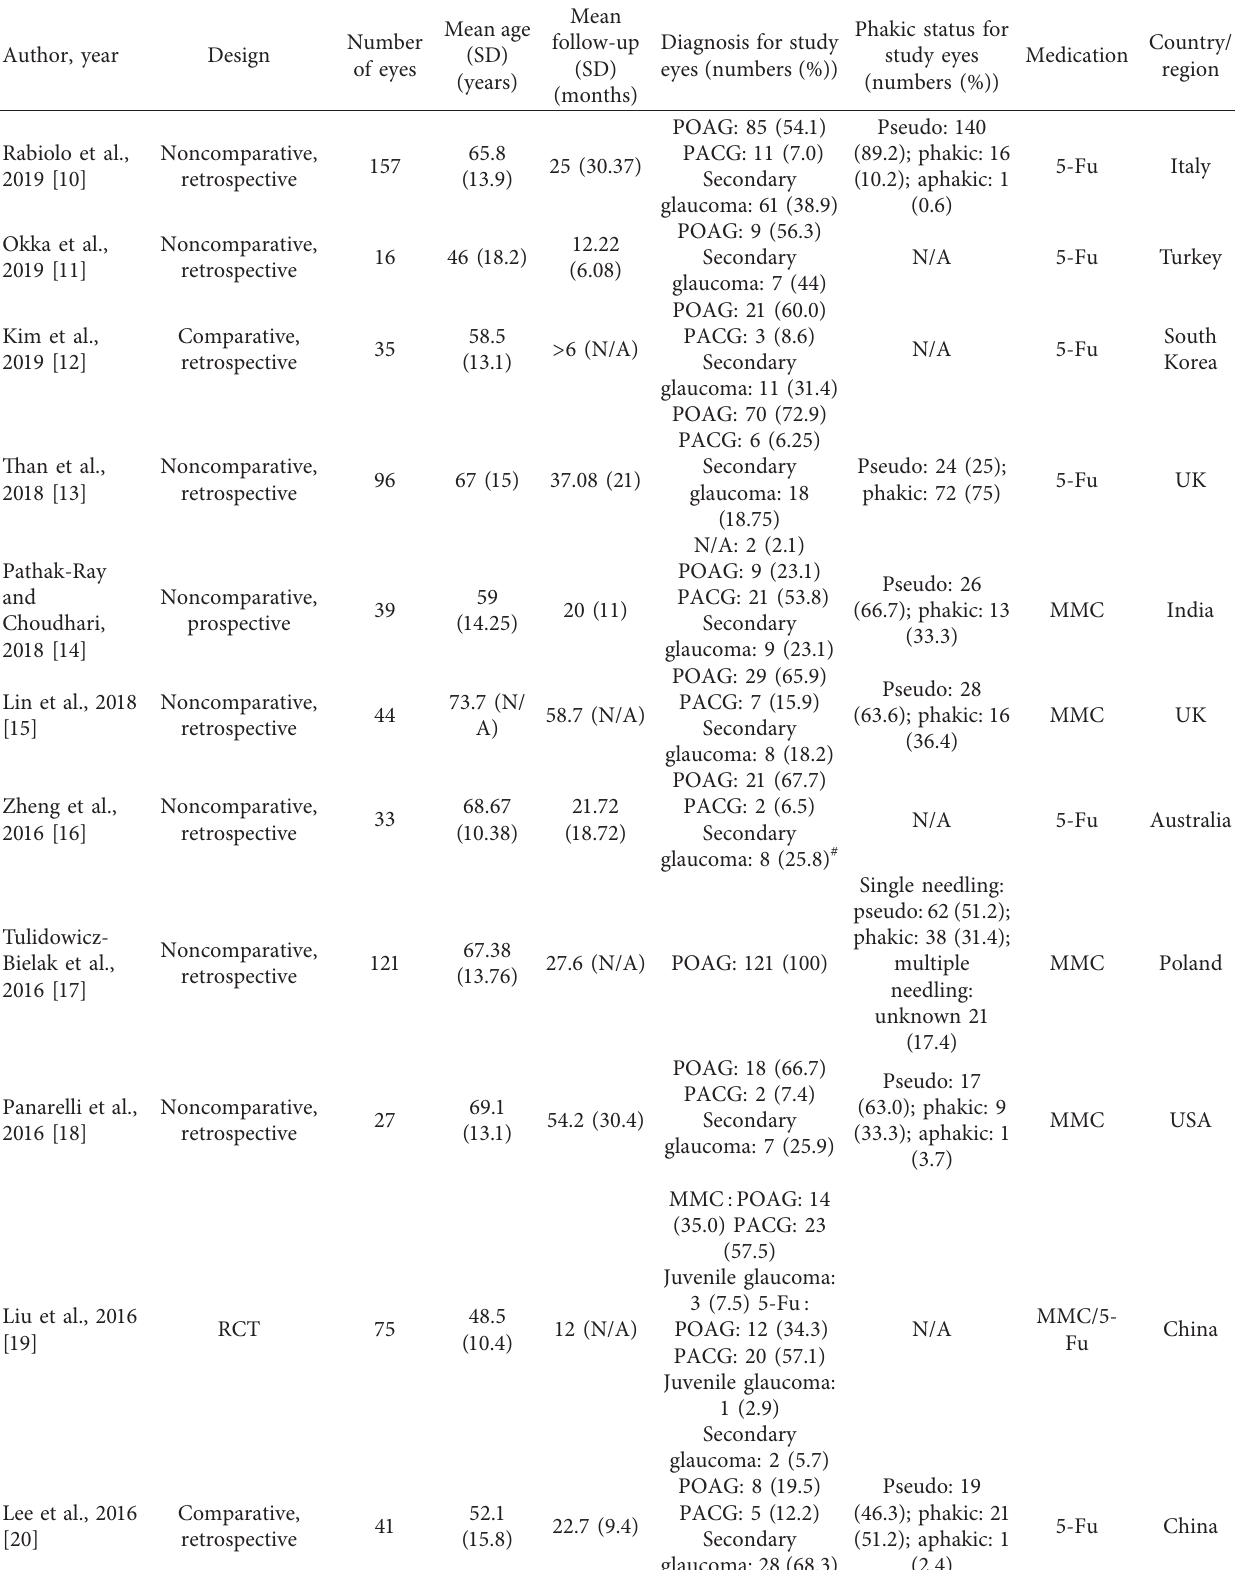
Table 1: Baseline characteristics of included studies.